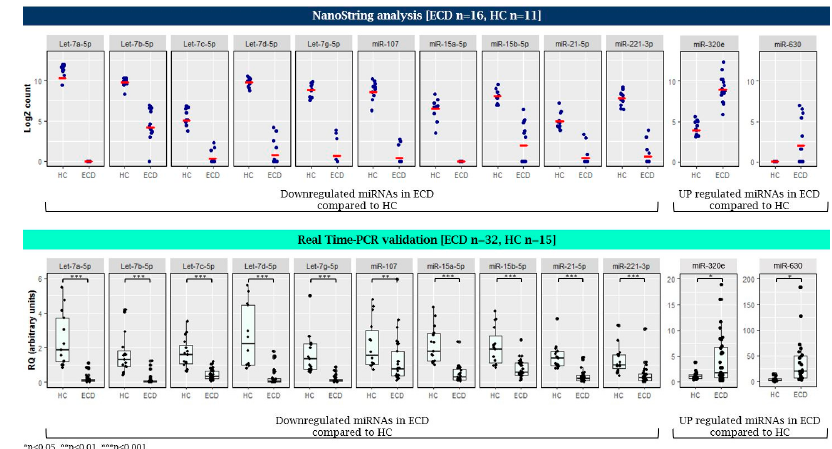
Figure 4. Validation of miRNAs expression in plasma samples of ECD patients and healthy controls (HC) by qRT-PCR (lower panel) following NanoString analysis (upper panel). qRT-PCR analysis was normalized to spike-in control cel-miR-39. RQ, relative quantification. * p < 0.05, ** p < 0.01, and *** p < 0.001.